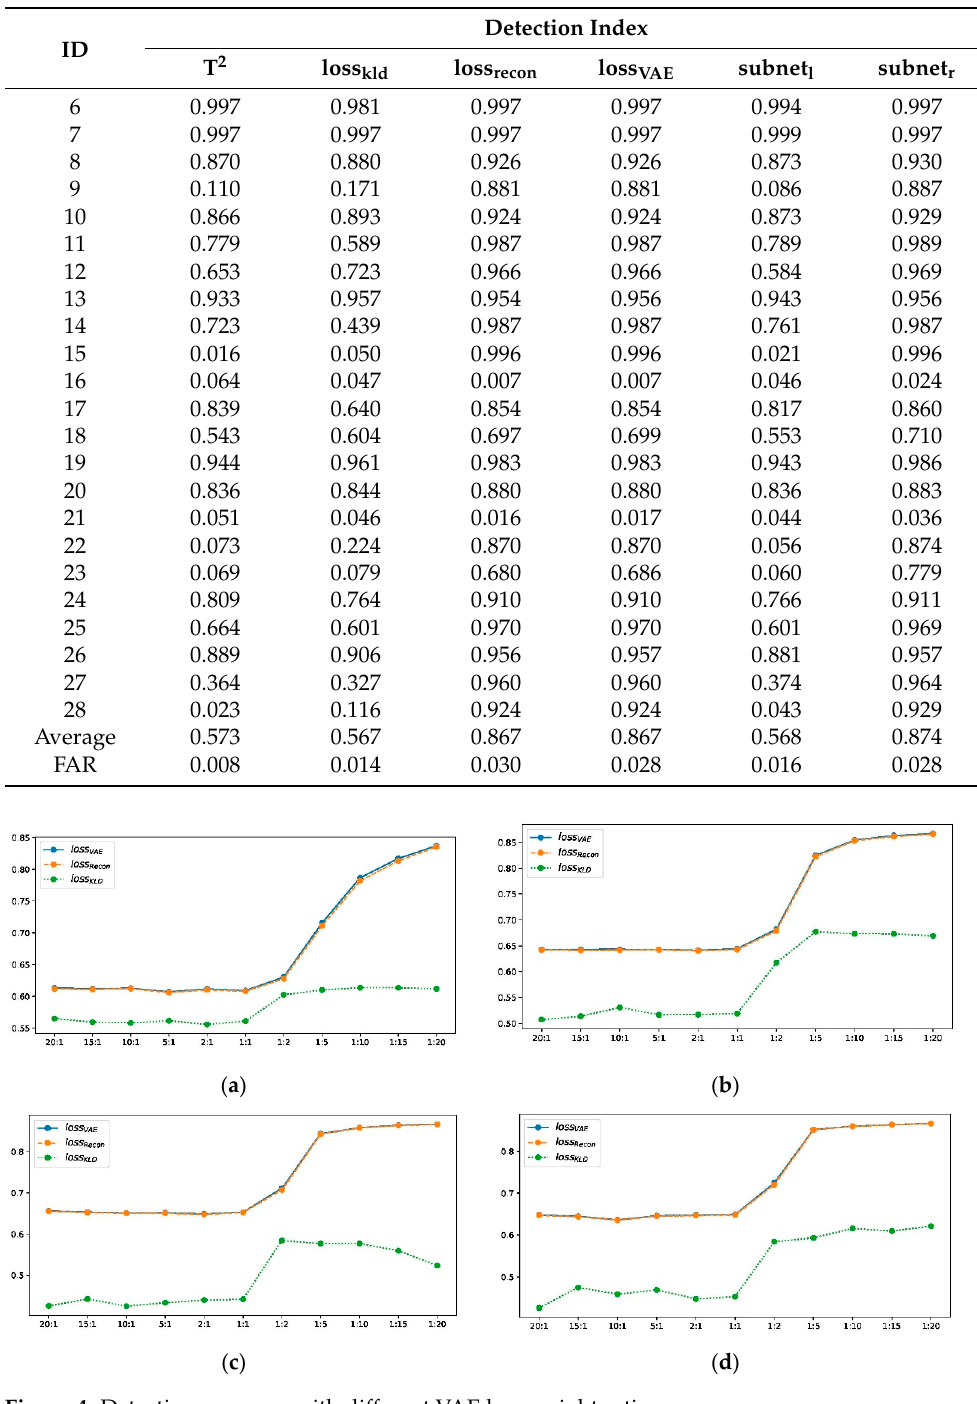
Figure 4. Detection accuracy with different VAE loss weight ratios. ( a ) VAE, ( b ) Dynamic VAE, ( c ) GRU-VAE, ( d ) LSTM-VAE.